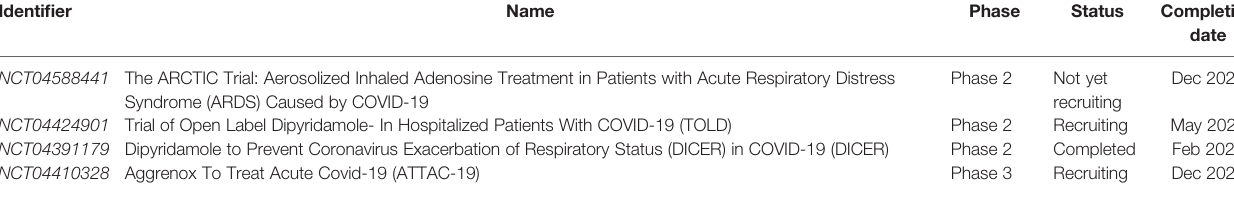
TABLE 2 | Clinical trials: adenosine enhancers in COVID-19 management.